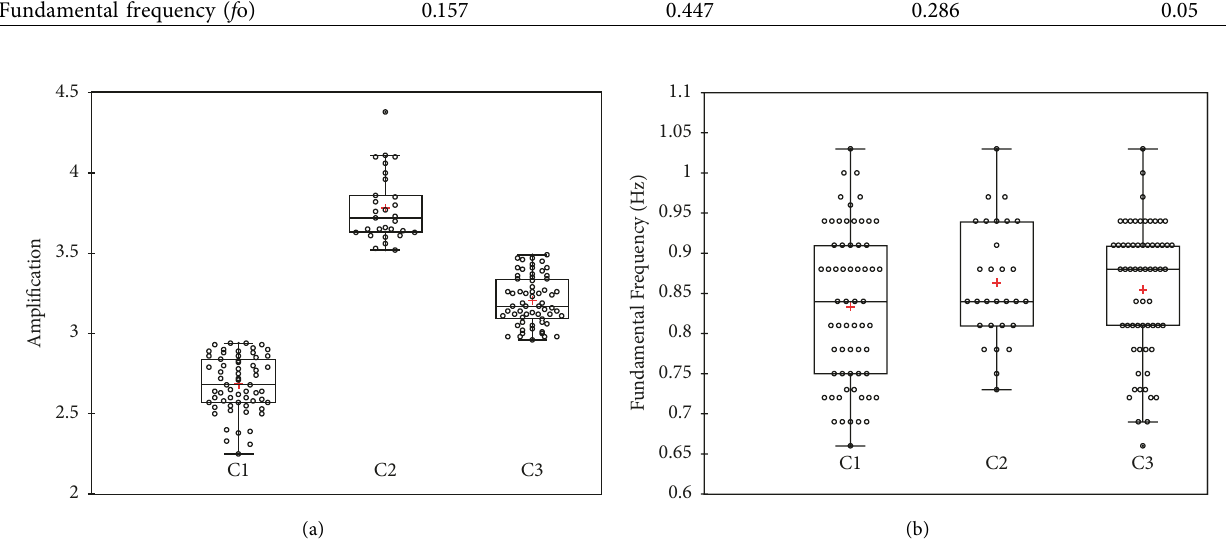
Figure 5: Box-plots showing the distribution of variables (a) Amplitude (Ao) and (b) Frequency (fo) by K-mean clustering technique.